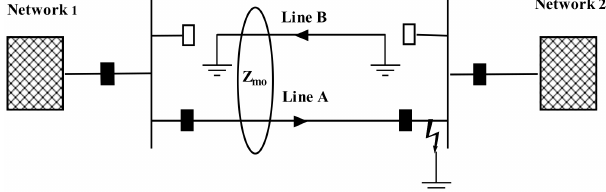
Figure 6. Parallel circuit switched off and earthed on both